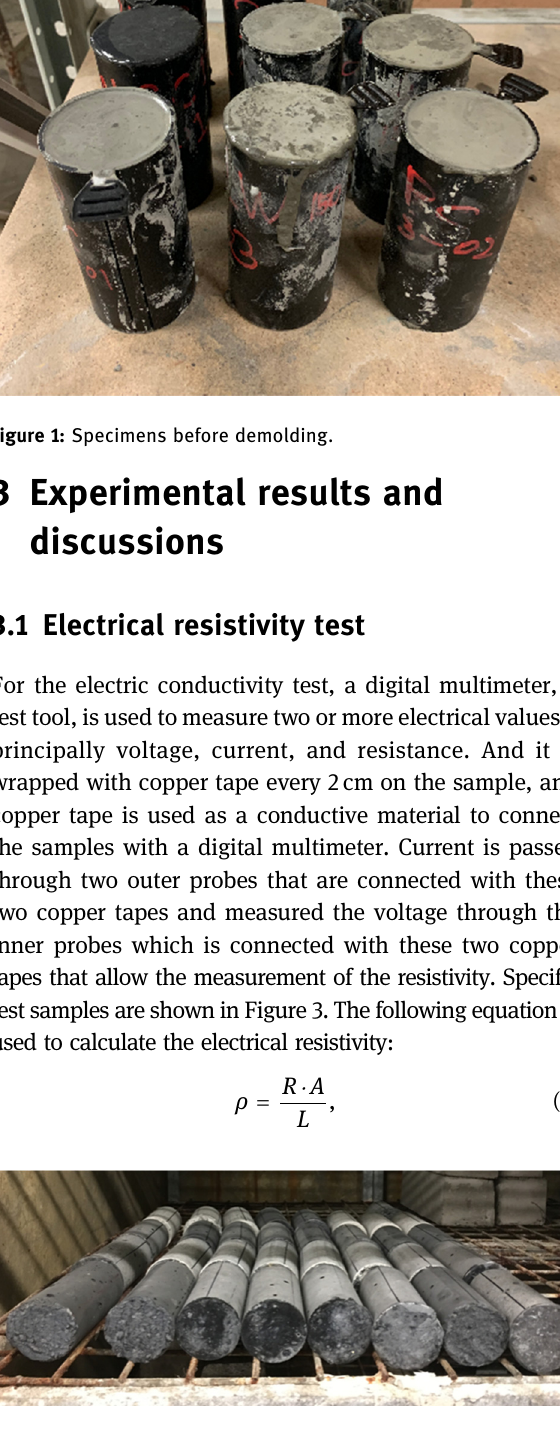
Figure 2: Specimens after curing